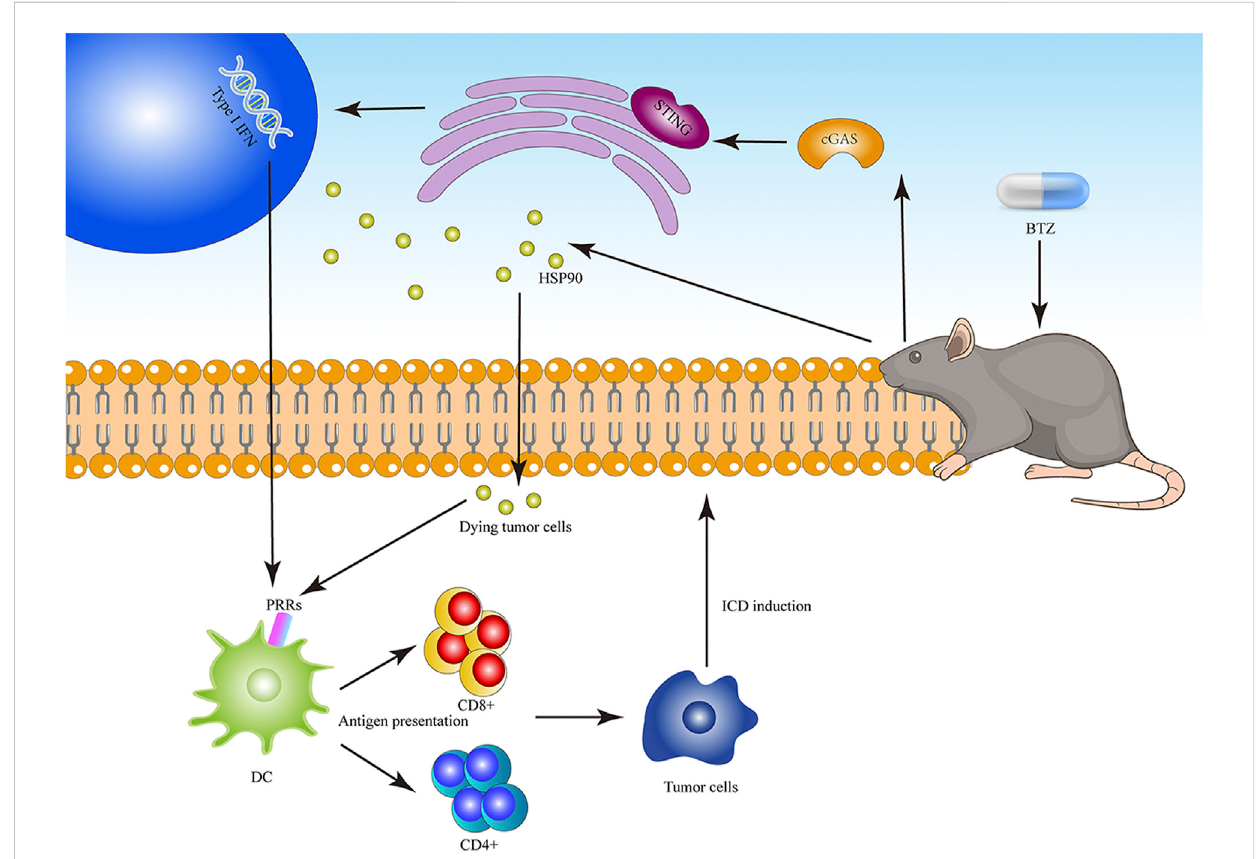
FIGURE 3 The diagram of BTZto induceICD. BTZ can signi fi cantly induce theexpression of HSP90 on thecell surfaceand mediate the maturation ofDC.BTZ triggers ICD by activating cGAS/STING pathway and producing type I